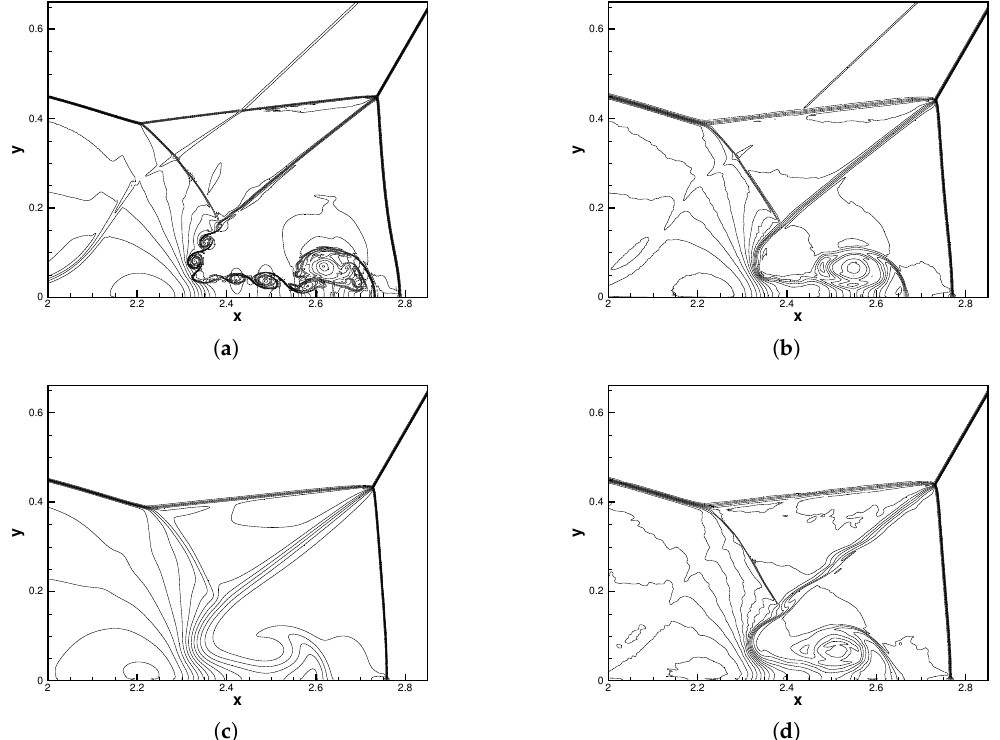
Figure 22. Density solution for the double Mach problem with 816 × 204 P 3 elements at t = 0.2. Thirty-three equally spaced contours from 1.75 to 22.7. ( a ) DB; ( b ) MDH; ( c ) MDA; ( d )